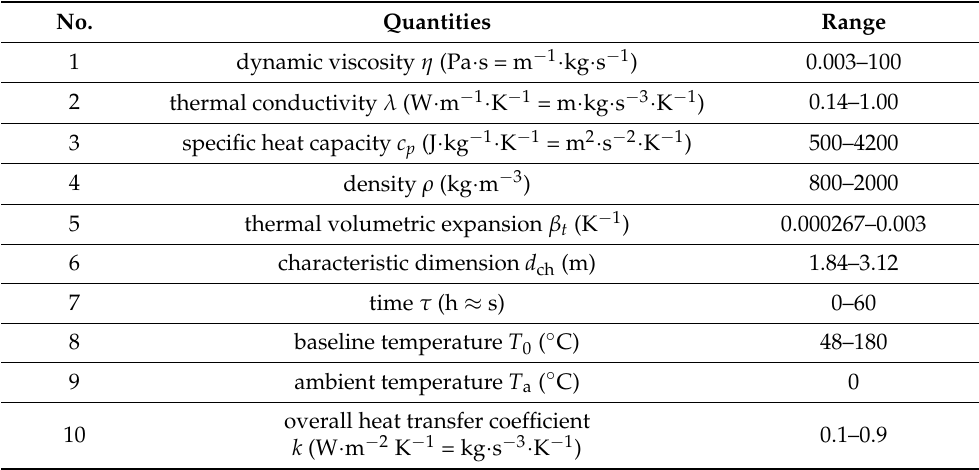
Table 1. Input quantities for the numerical